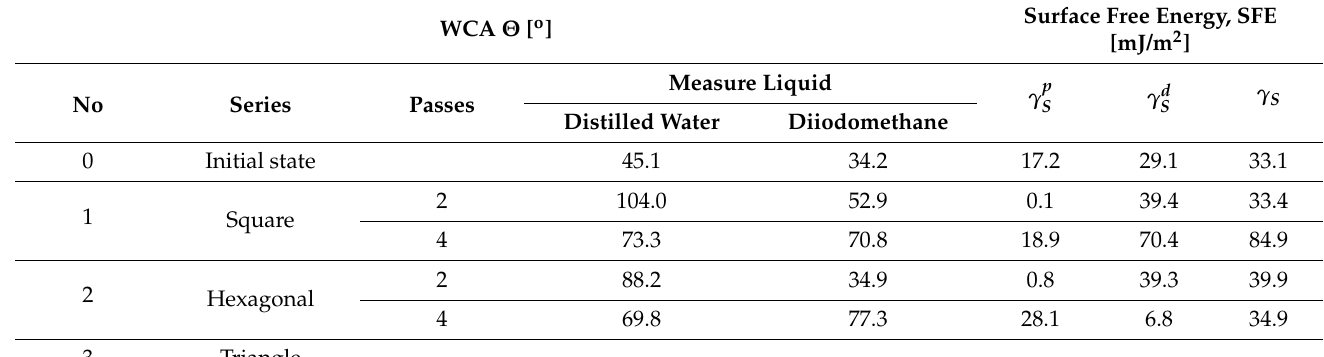
Table 3. SFE and WCA